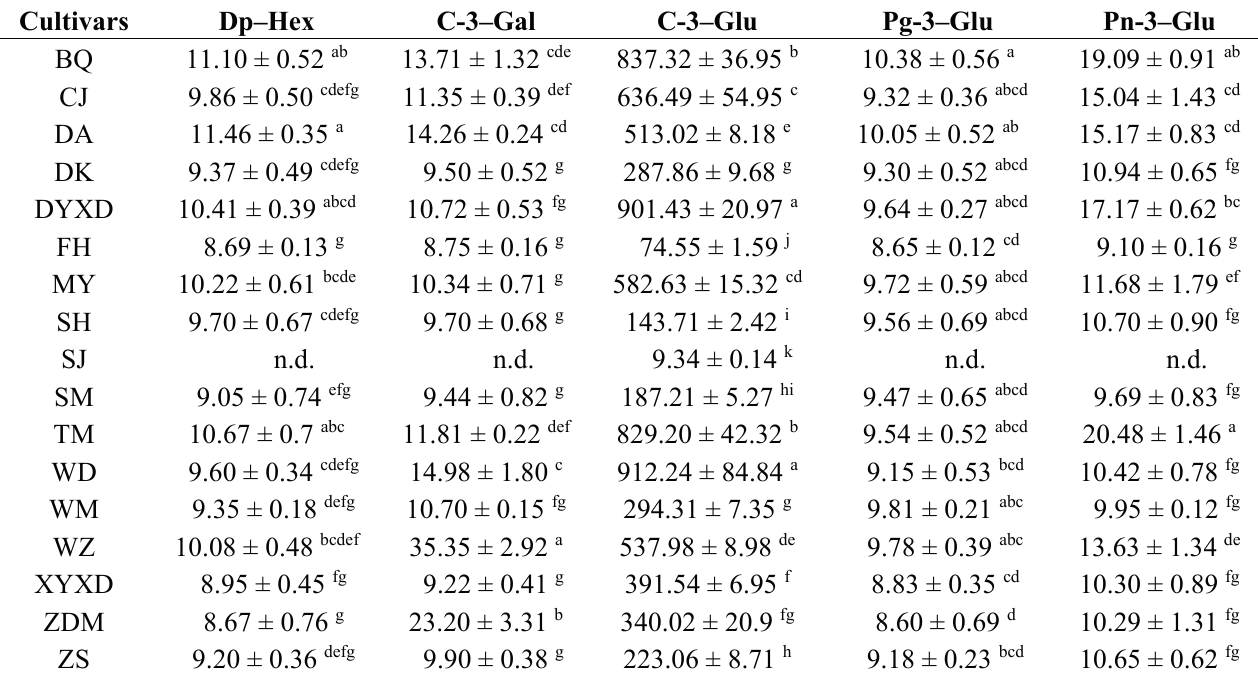
Table 4. Anthocyanin contents ( μ g/g FW) in the pulp of the 17 Chinese bayberry cultivars.